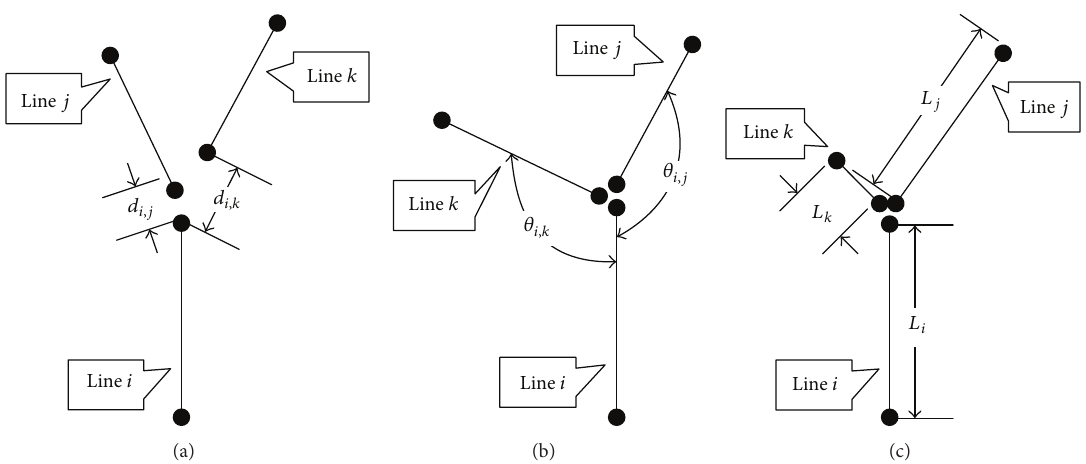
Figure 4: Relationship and merging degree between line segments. (a) Distance between line segments 𝑖 and 𝑗 is shorter, corresponding to higher merging degree. (b) Intersection angle between 𝑖 and 𝑗 is larger, corresponding to higher merging degree. (c) Lengths of line segments 𝑖 and 𝑗 are more similar, corresponding to higher merging degree.